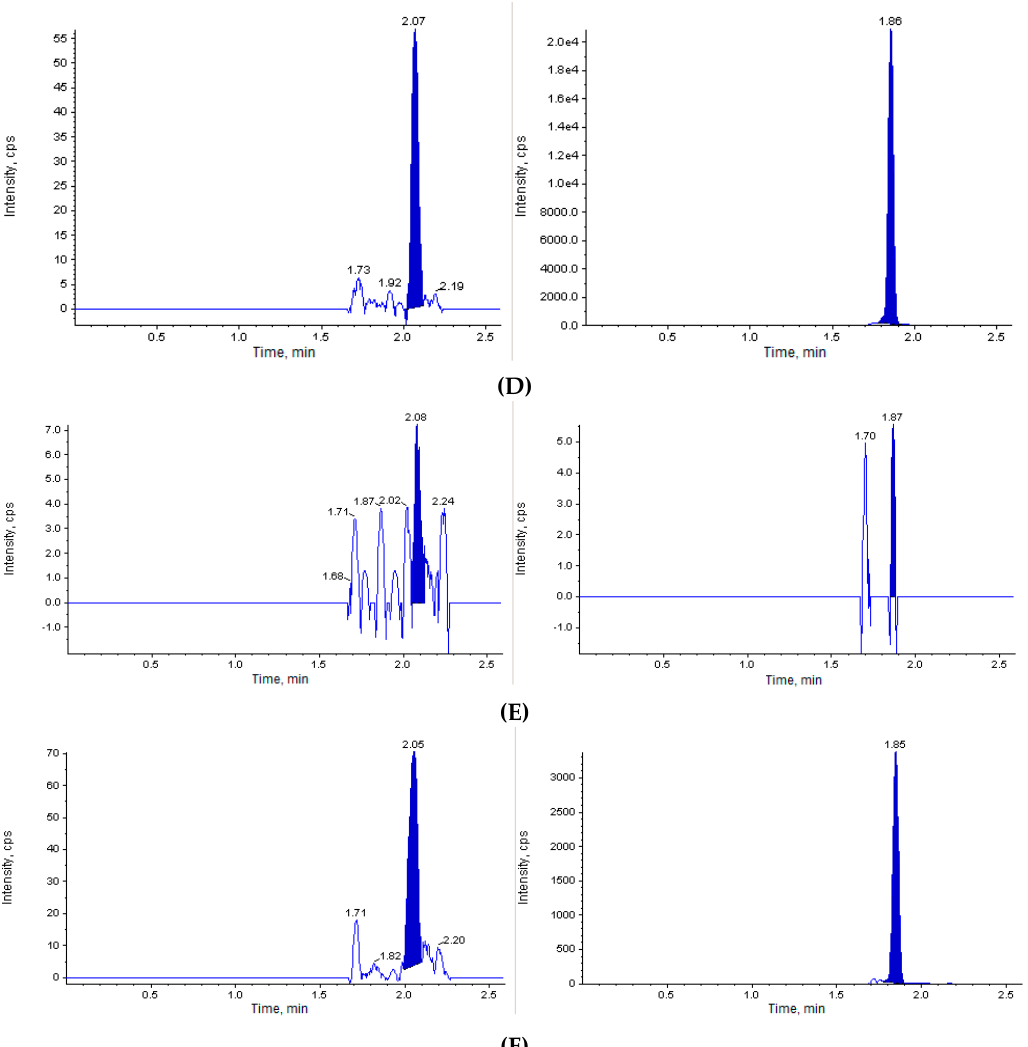
Figure 2. Chromatographic plots from the in vivo investigation of the acute toxicity of Les-3833 in male Balb/c mice. ( A ) blank plasma sample, ( B ) blank plasma spiked with Les-3833 (5 ng/mL, left panel) and internal standard (IS, dactinomycin, right panel), ( C ) blank brain sample, ( D ) blank brain sample spiked with Les-3833 (10 ng/g, left panel) and IS (right panel), ( E ) blank liver sample, and ( F ) blank liver sample spiked with Les-3833 (50 ng/g, left panel) and IS (right panel). After IV administration, the Les-3833 concentration in blood plasma reached its maximum at 1.88 to 2.23 min. The peak concentration was observed at 2.08 min after the IV injection. The maximum plasma concentration of Les-3833 was 5.55 ± 0.25 ng/mL, and the half-life of its elimination was 15 min (Figure 3, Table 3).